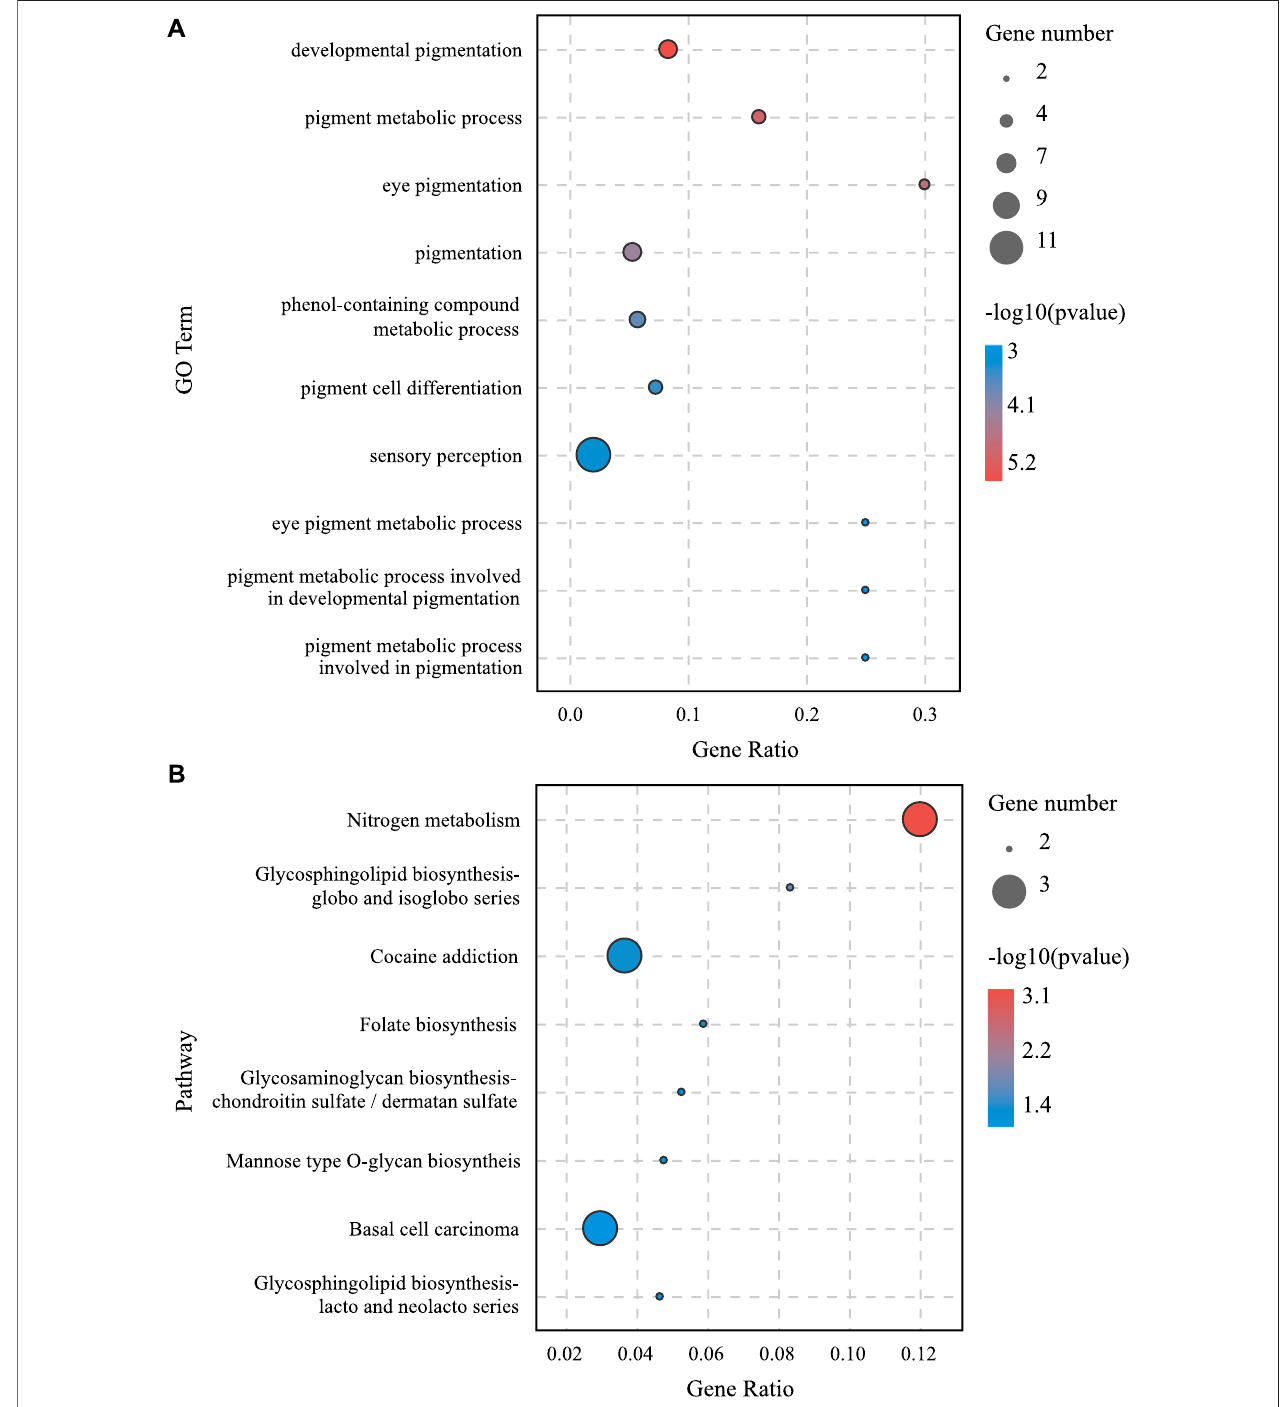
FIGURE 7 | (A) GO enrichment analysis in the biological process for DEGs involved in the lncRNA – miRNA – mRNA network between BN and BH. (B) KEGG pathway enrichment analysis results for DEGs involved in lncRNA – miRNA – mRNA network between BN and BH.